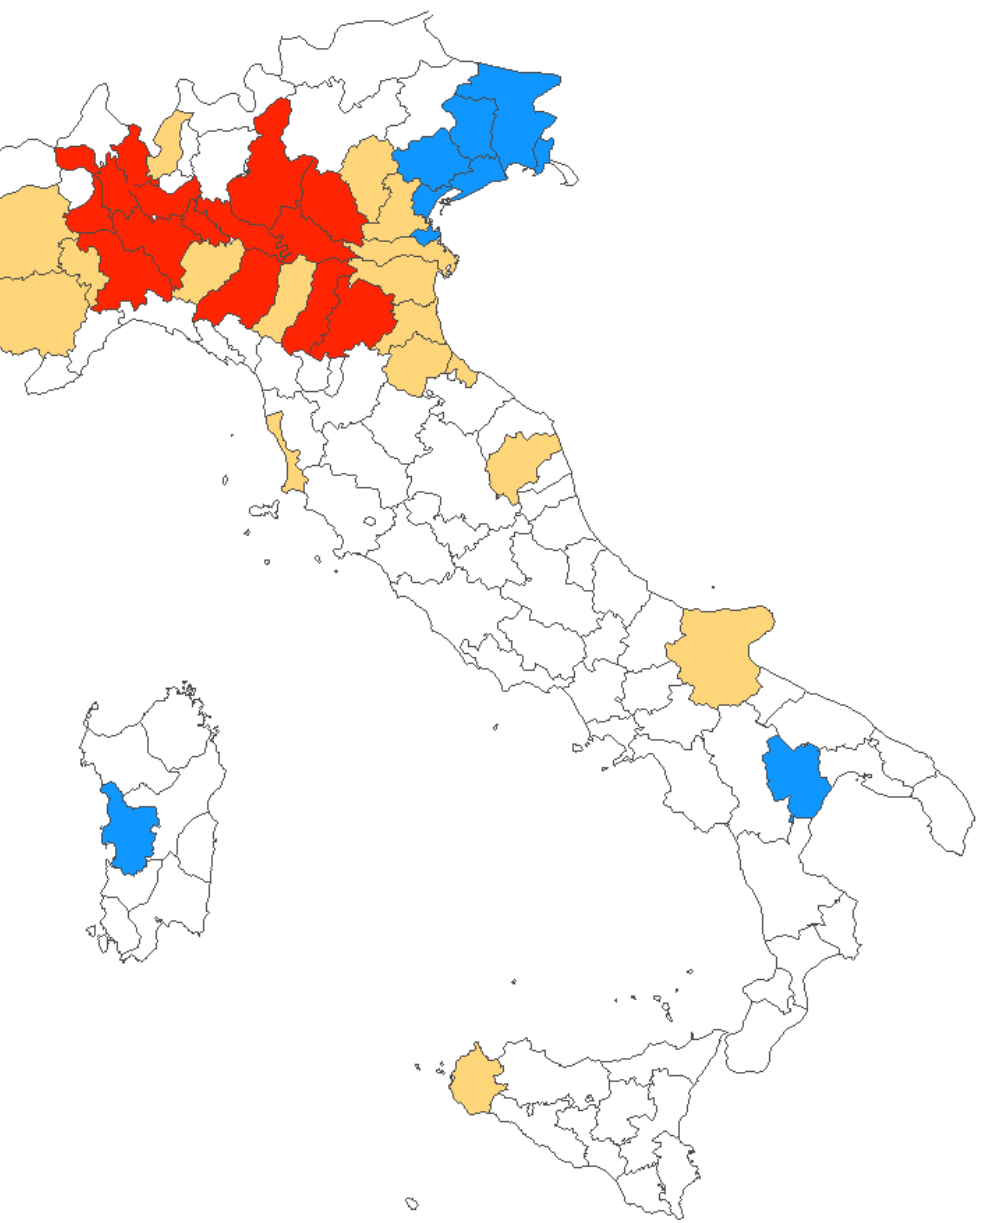
Figure 4. Italian provinces characterized by human WNV infections between 2012 and 2020. In blue, areas where diagnoses were originally reported in 2012; in red, all provinces with cases reported in 2020; and in yellow provinces where at least one case of WNV infections was reported between 2013 and 2019.